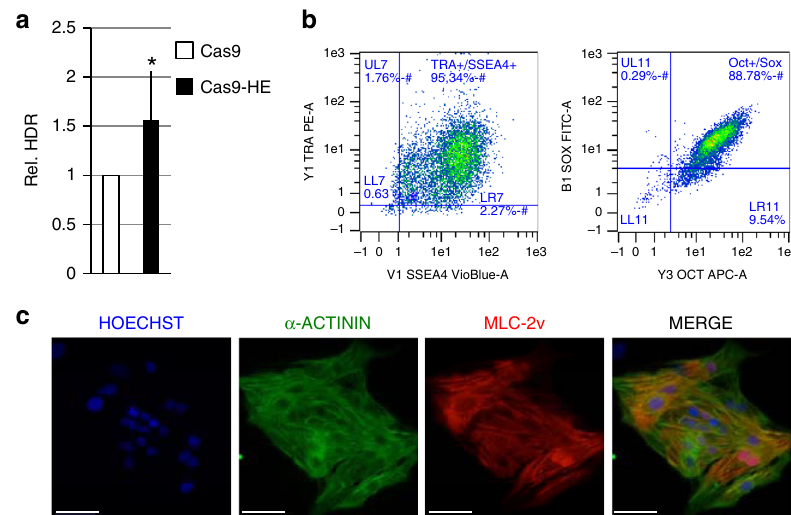
Fig. 4 Stimulation of transgene integration by Cas9 – HE in iPS cells. a Relative frequencies of HDR induced by Cas9 – HE at DNA cleavage site directed by T2 guide RNA. Human iPS cells were transfected with the indicated Cas9 plasmids, T2 guide RNA, and puromycin transgene donor with 800-bp homology arms to the AAVS1 locus. HDR-mediated transgene integration was measured by counting puromycin-resistant clones, resulting from targeted integration at the AAVS1 locus of the puromycin resistance exon carried by the transgene. The results are expressed as the mean relative number of puromycin- resistant clones after normalizing the number of puromycin-resistant clones by that induced by Cas9. The difference between Cas9 – HE and Cas9 was statistically signi fi cant ( t -test, * P <0.05). Data represented are from four independent experiments. Error bars indicate standard deviation. b A clone of puromycin-resistant cells derived from puromycin selection of cells transfected with Cas9 – HE, T2 guide RNA, and puromycin-resistant transgene donor was analyzed for expression of stemness markers TRA-1-60 and SSEA4 or Oct3/4 and Sox2 by FACS analysis. c After induction of cardiomyocyte differentiation in the clone analyzed in b , expression of cardiomyocyte markers alpha-actinin and MLC2-v was analyzed by immunohistochemistry. Scale bar, 50 µ m